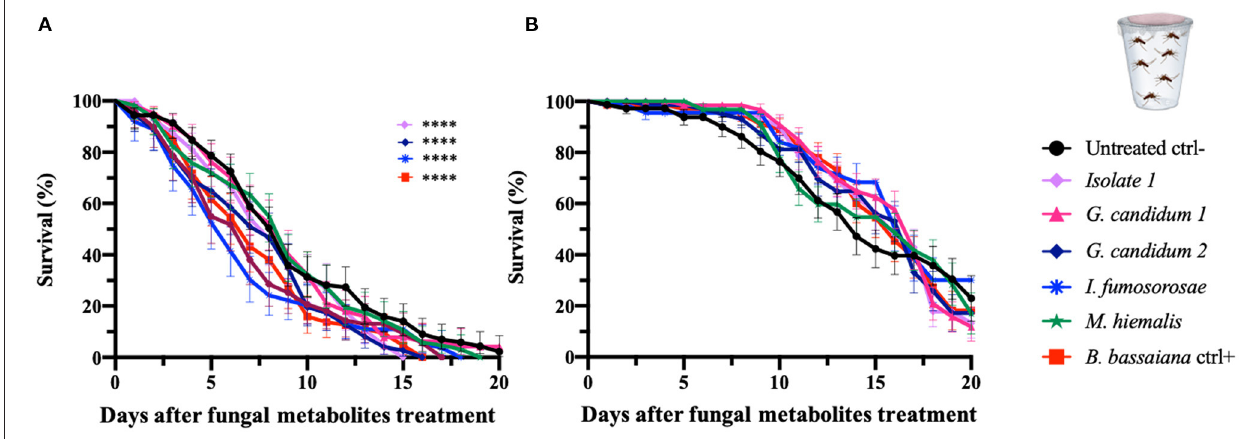
FIGURE 3 | Fungal metabolite assays of An. gambiae and Ae. aegypti mosquitoes. Mosquitoes were allowed to feed on a sucrose solution containing fungal metabolites (free from spores and mycelium) for 48h, and the mosquito survival was monitored for 20 days. Data here are presented for An. gambiae (A) and Ae. aegypti (B) . The metabolites used in the experiments are derived from the fungi identified as active against An. gambiae in the initial screen (direct exposure experiment) and were collected from fungal liquid culture. The graphs represent the average and standard deviation of three biological replicates, N = 30 females per replicate. As a negative control, mosquitoes were fed on a metabolite-free solution, and as a positive control on metabolite solutions from B. bassiana . The statistical significance of the results for each fungus was compared to the negative control and analyzed by log-rank Mantel-Cox test; p -values are presented in Table 4 . to have both larvicidal and adulticidal activity against Ae. aegypti has been shown to have pathogenic activity against the strawberry mosquitoes (Meepagala et al., 2018), and exposure to its conidia pest Duponchelia fovealist (Amatuzzi et al., 2018). The Fusarium